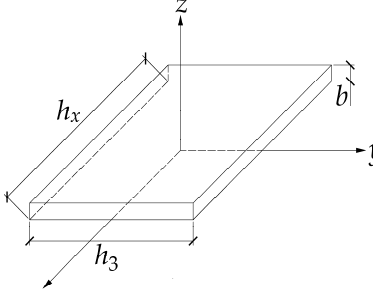
Figure 1. Concrete retaining wall simulation plate three ‐ dimensional coordinate system.